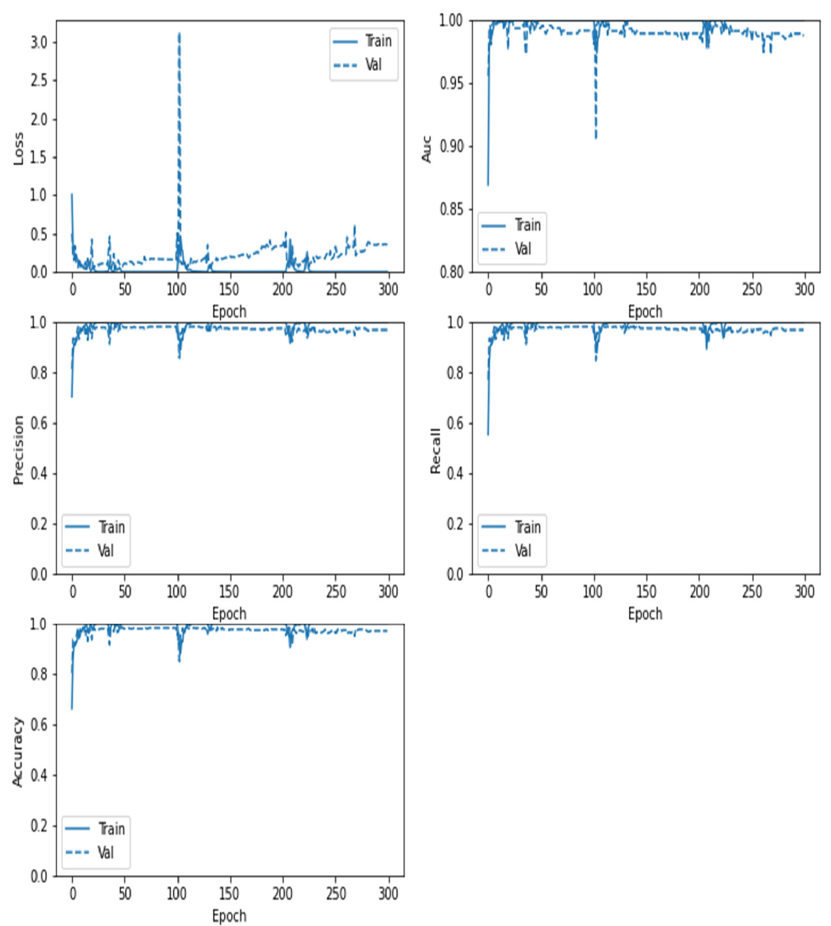
Figure 11. Loss, AUC, precision, recall, and accuracy between the training and validation phases with the number of epochs for the MobileNetV2 model using DCGAN image generated. Similarly, in Figure 12, the confusion matrix of the ResNet152V2 model shows that the brain tumor and No-Tumor classification statues with the highest ratio to the Tumor images (0.987) and total accuracy of 0.9794 and misclass value of 0.0206 for Vanilla GAN generated images as in Figure 12a whereas the highest ratio using the DCGAN generated images is for the Tumor images (0.993) with total accuracy 0.9909 and misclass value of 0.0091 as in Figure 12b. For the ResNet152V2 model, Figure 13 plots the loss in AUC, pre- cision, recall, and accuracy as a function of the number of training and validation epochs in each phase.